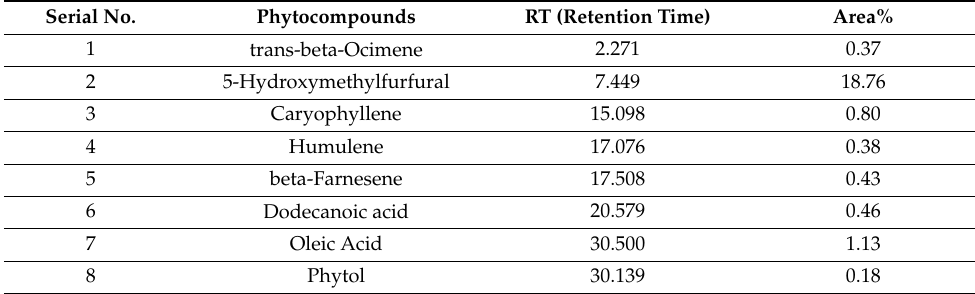
Figure 2. Total ion chromatogram (TIC) of Syzygium cumini (L.) Skeels. The lines in chromatogram represent different compounds along with their respective retention time. Table 1. Phytocompounds detected by GC-MS in Syzygium cumini (L.) Skeels. Serial